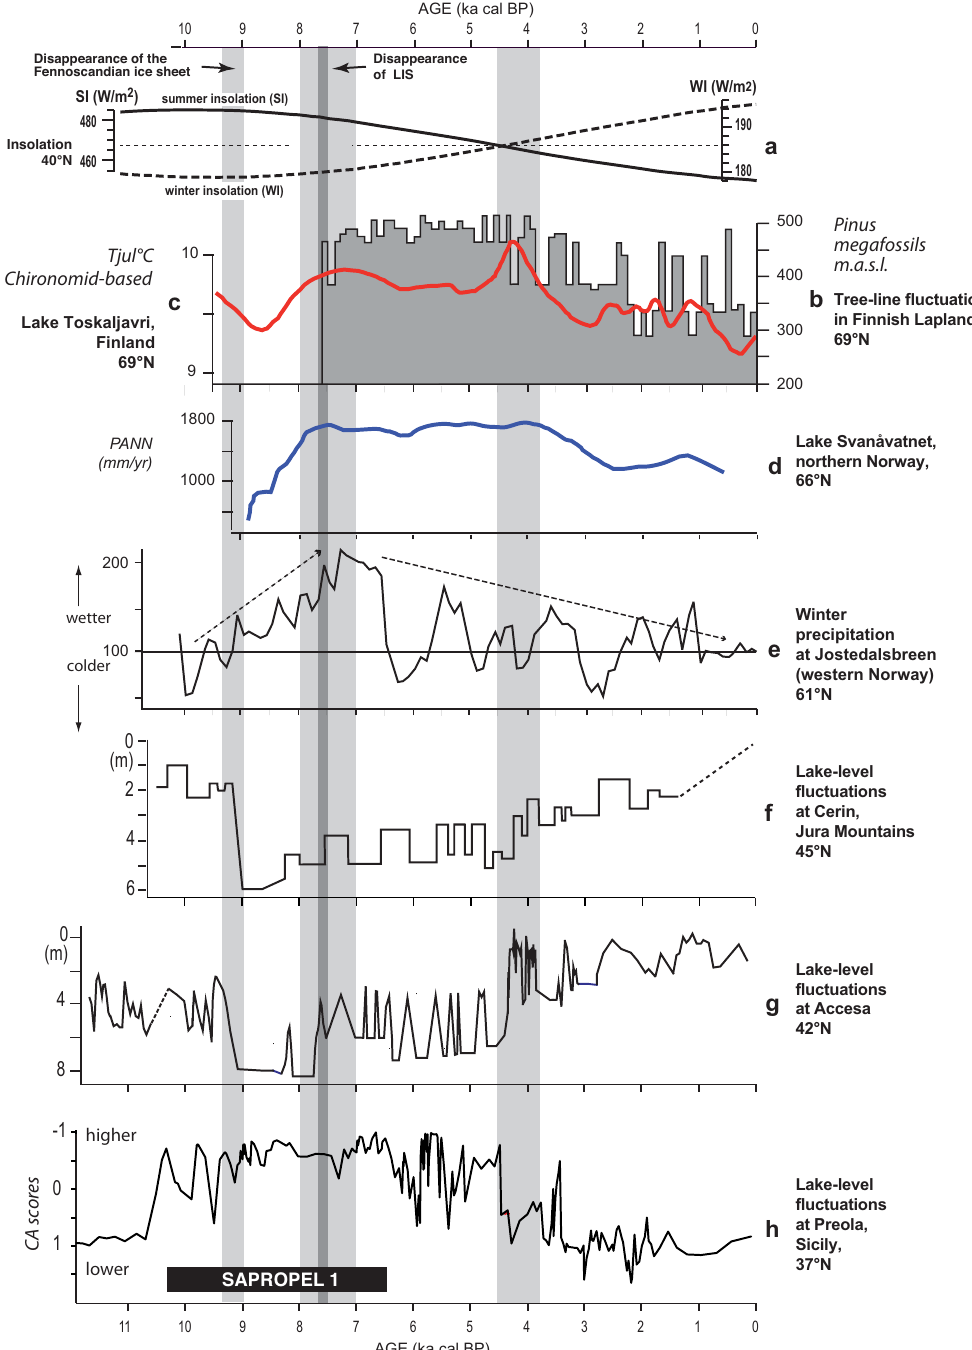
Figure 6 Fig. 6. Comparison between palaeohydrological and palaeoclimatic records along a north–south transect from Scandinavia to